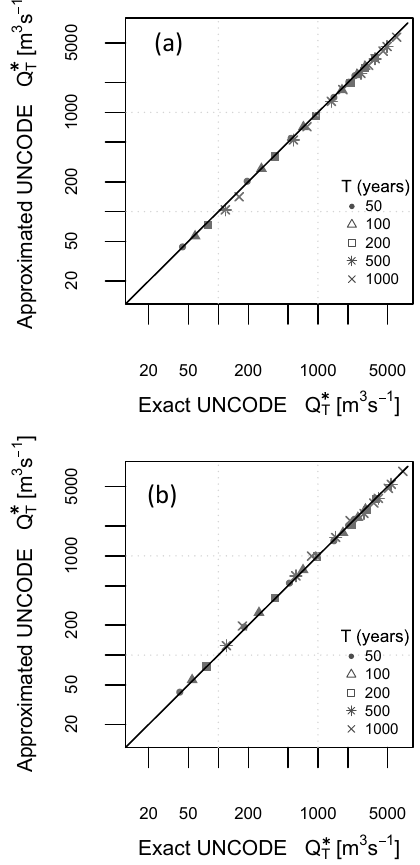
Figure 2. Comparison between the exact, Q ∗ ˆ Q ∗ , UNCODE estimators of the design flood for a pool of six T flood records considered in Botto et al. (2014, Table 1) with at least 30 years of data. Different return periods are listed in the legend. The reference distribution used for this flood frequency analysis is the three-parameter log-normal (LN3) in (a) and the generalized ex- treme value (GEV) in (b)